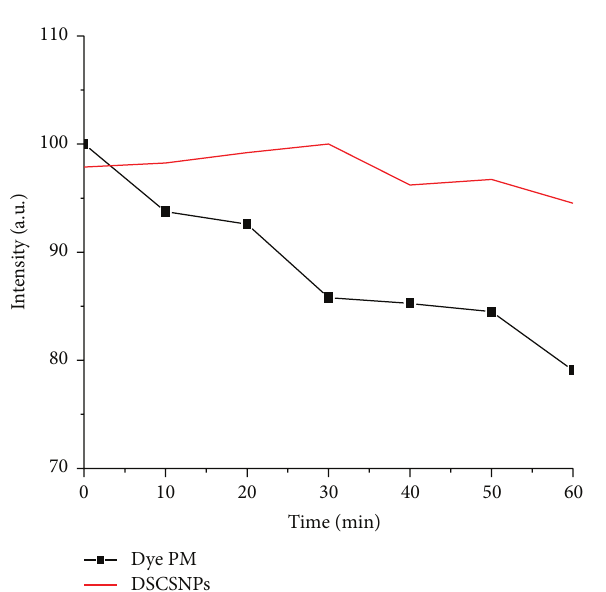
Figure 7: Emission stability of PM597 dye and PM 597/SiO 2 core/shell NPs under pulsed laser excitation during 60 minutes.